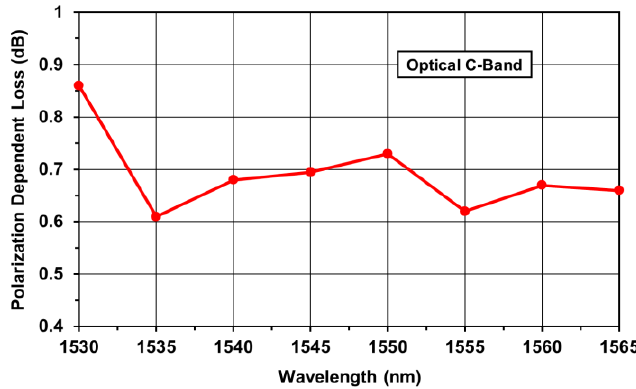
Figure 6. Measured polarization dependent loss plotted against the optical wavelength for a bias voltage of −8 V.